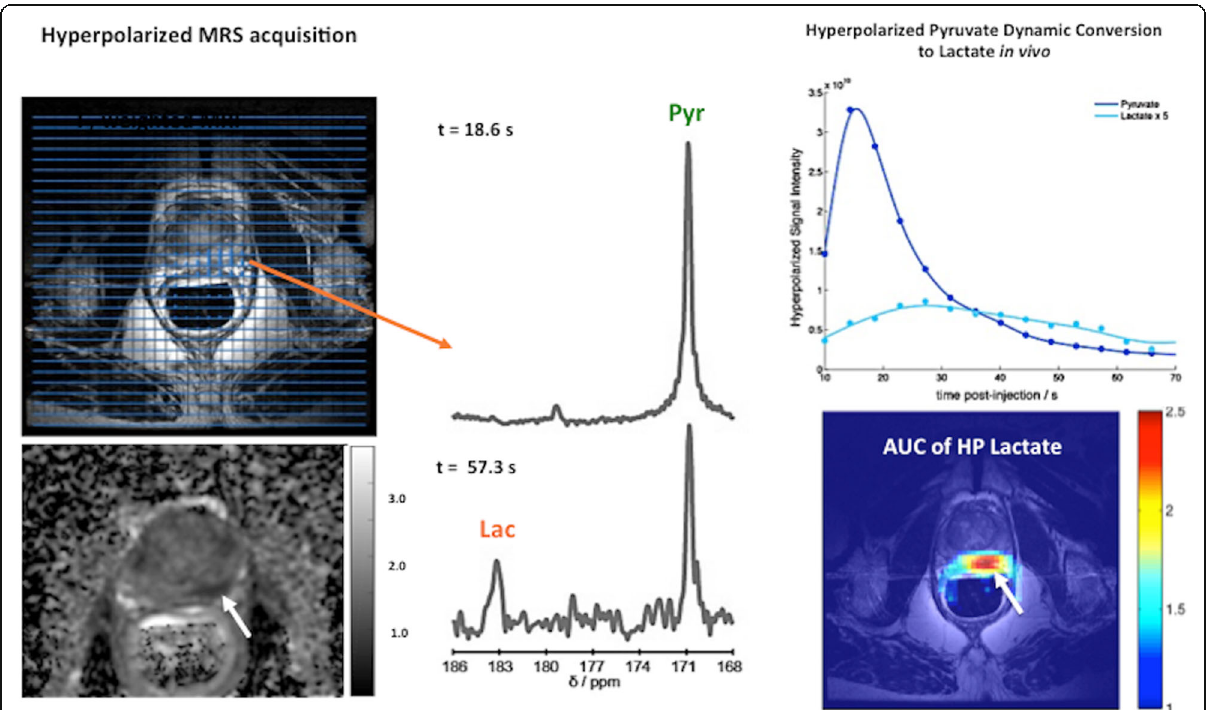
Fig. 17 A 71-year-old man with a Gleason 7 prostate cancer (PSA 6.05). A suspicious area with low ADC values was depicted in the left peripheral area (white arrow). The hyperpolarized 13 C spectra and the time course for the dynamic conversion hyperpolarized [1-13C] pyruvate to lactate following the injection of hyperpolarized pyruvate were revaluated (top, right). Note the change of the MR spectra with the pyruvate quickly reached a maximum at t : 57.3 s (bottom, middle) before being converted to lactate. Compared with the spectrum at t : 18.6 s (top, middle). [Images courtesy of Kayvan R Keshari, PhD. Laboratory Head. Memorial Sloan Kettering Cancer